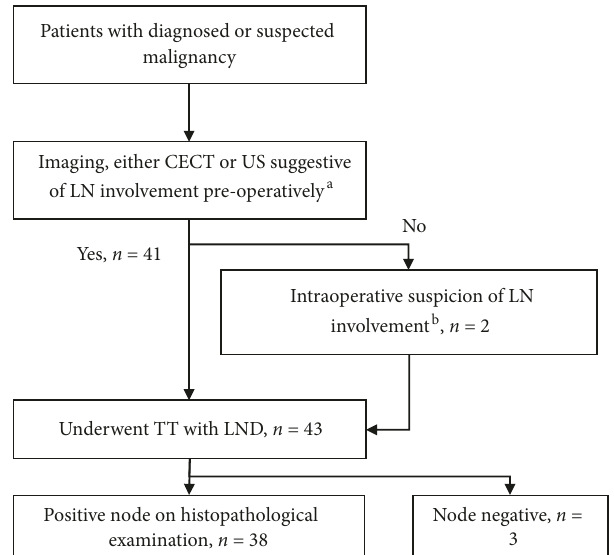
Figure 1: Yield of lymph node metastases among those who under- went total thyroidectomy (TT) and lymph node dissection (LND) based on imaging or intraoperative suspicion. CECT, contrast enhanced computed tomography; US, ultrasound; LN, lymph node; TT, total thyroidectomy; LND, lymph node dissection. a Suspicious imaging findings include enlarged cervical lymph nodes with short axis more than 5 mm, calcifications, cystic changes, peripheral vascularity, rounded shape, hyperechogenicity, or obliteration of fattyhilum[6]. b Suspiciousintraoperativefindingsofcervicallymph node metastases include hard and ill-defined nodes, as well as adherence to surrounding